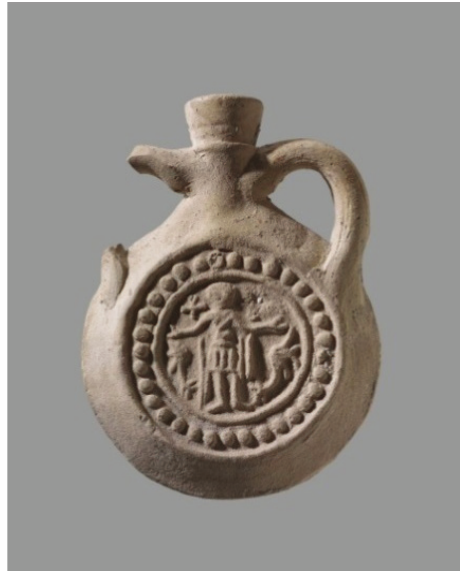
Figure 4: ampulla : Saint Menas (BM No.1876,0520.4). © Trustees of the British